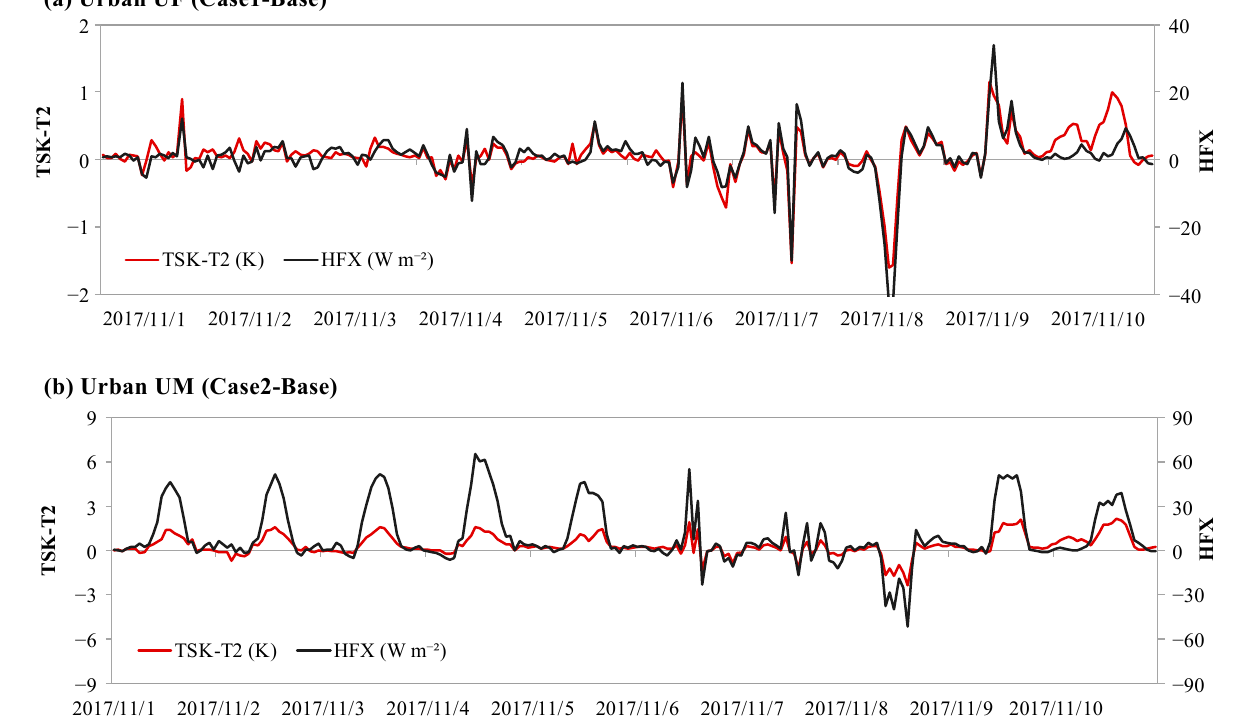
Figure 9. Mean time series of the impacts of the high-resolution UF and UM on the simulated TSK—T2 and HFX in an urban centre. ( a ) Effect of UF (Case 1—Base); ( b ) effect of UM (Case 2—Base).